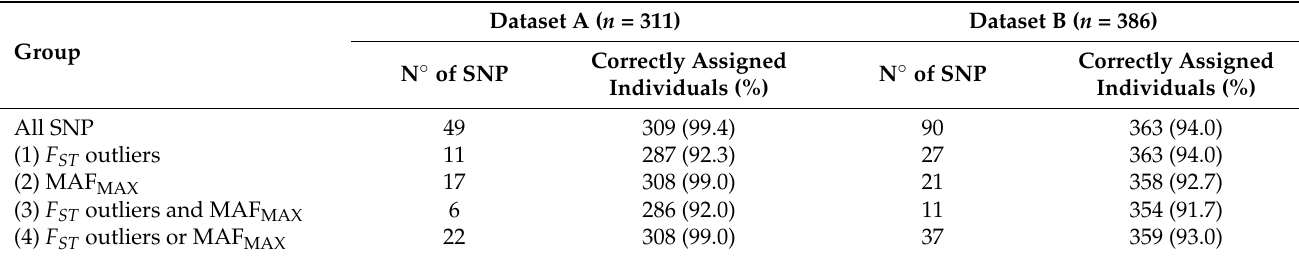
Table 3. Assignment success in datasets A and B by criteria.